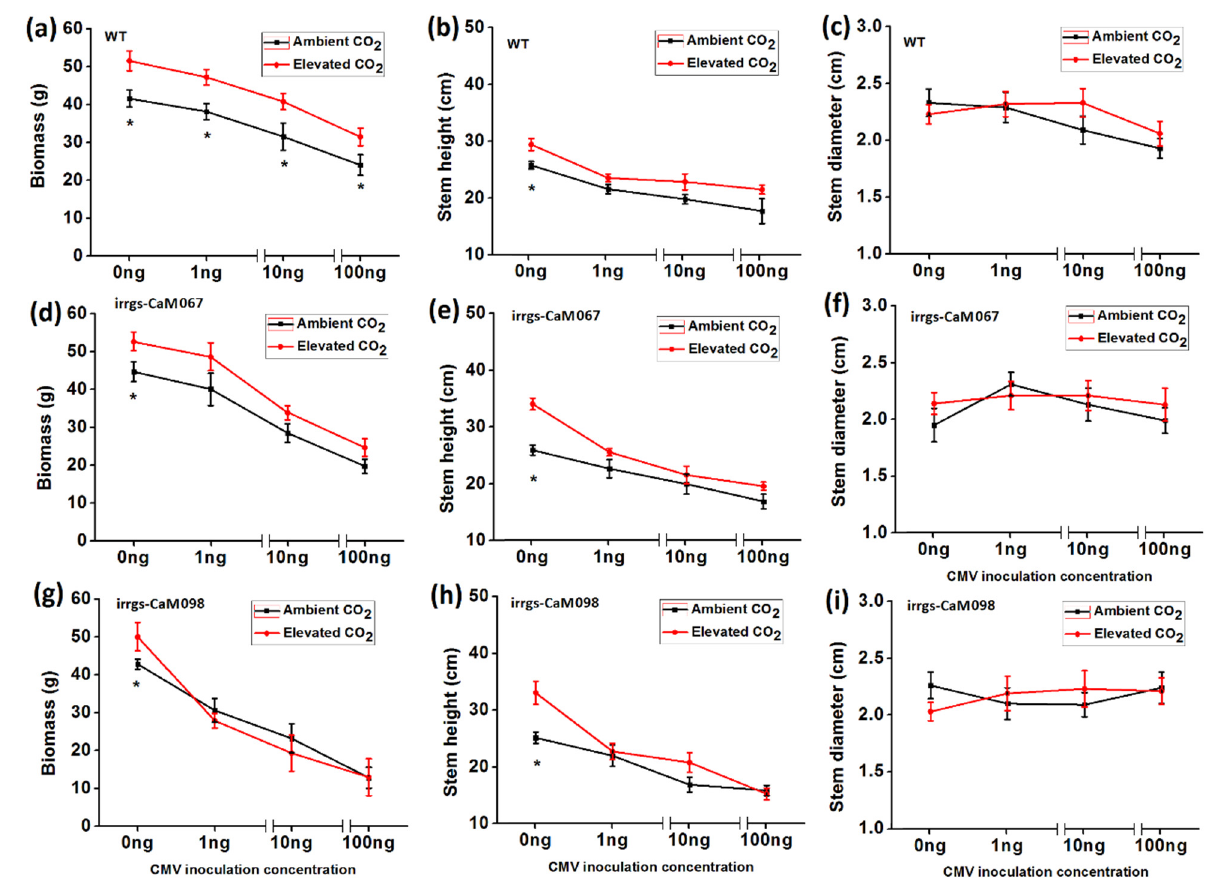
Figure 6. Growth traits of two N. tabacum genotypes (WT, irrgs-CaM067, irrgs-CaM098) grown under ambient CO 2 (ACO 2 ) and elevated CO 2 (ECO 2 ) with different CMV inoculation concentration. Data represent means ± SE (Tukey’s multiple range test, p < 0.05). ( a ) biomass, ( b ) stem height and ( c ) stem diameter of wild-type (WT) plants. ( d ) biomass, ( e ) stem height and ( f ) stem diameter of irrgs-CaM067 plants. ( g ) biomass, ( h ) stem height and ( i ) stem diameter of irrgs-CaM098 plants.